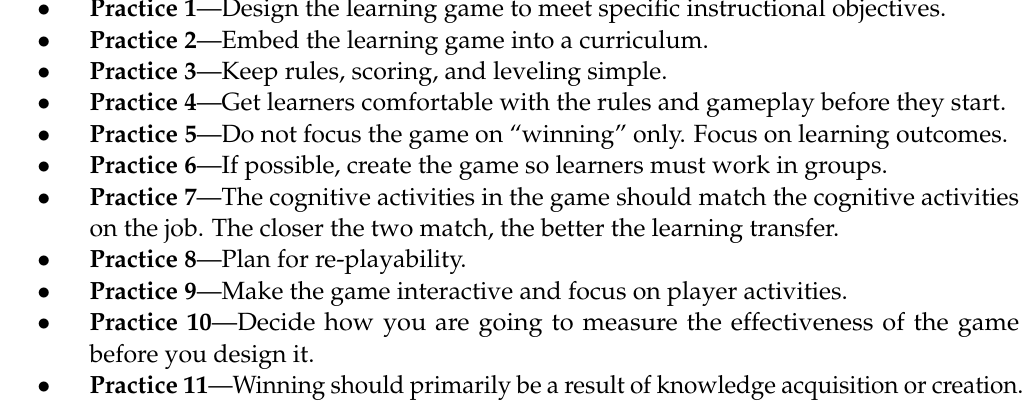
Table 1. Self-Evaluation of Dealodontics relative to Best Practices for Learning Game (Adapted from “The Gamification of Learning and Instruction Fieldbook”) [56].